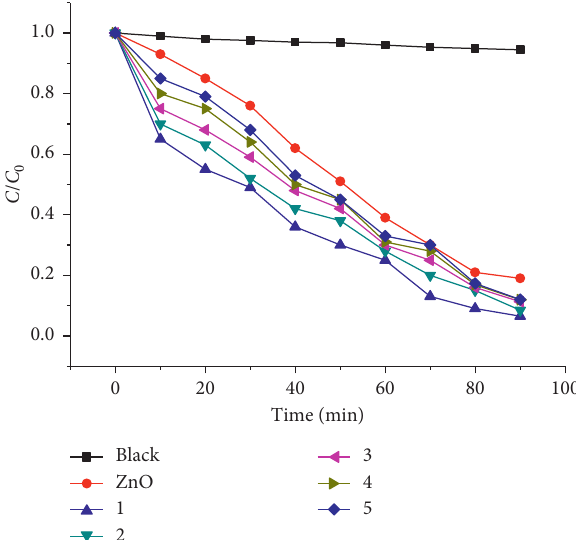
Figure 26: MB concentration plotted as a function of the exposure time for the ZnO/sepiolite composites prepared by five different methods